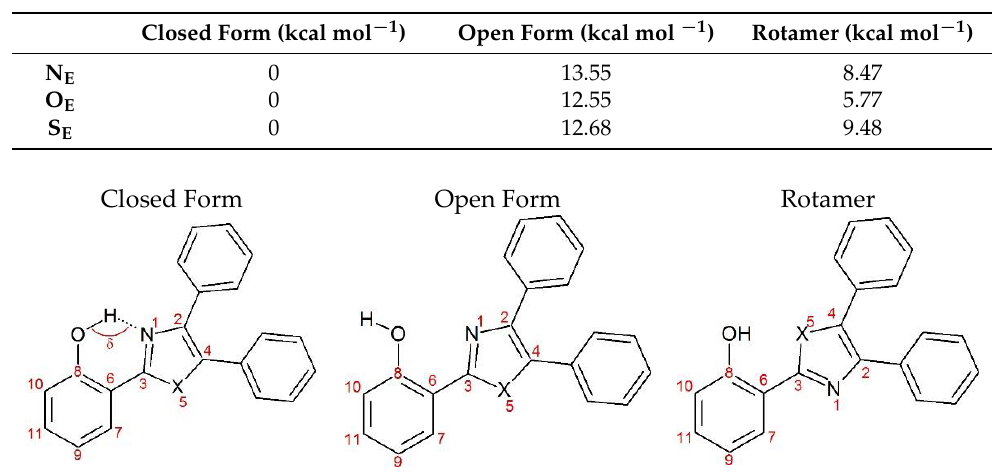
Table 1. Relative free energy, in kcal mol − 1 , for the N E , O E , and S E in the ground state, in the closed, open, and rotamer forms.